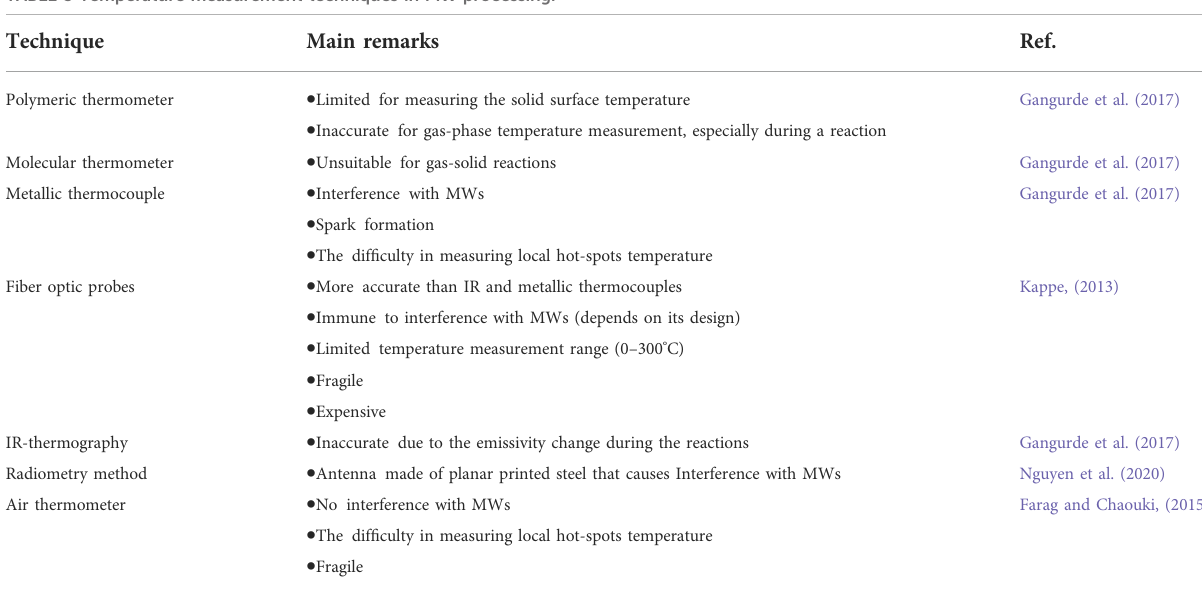
TABLE 3 Temperature measurement techniques in MW